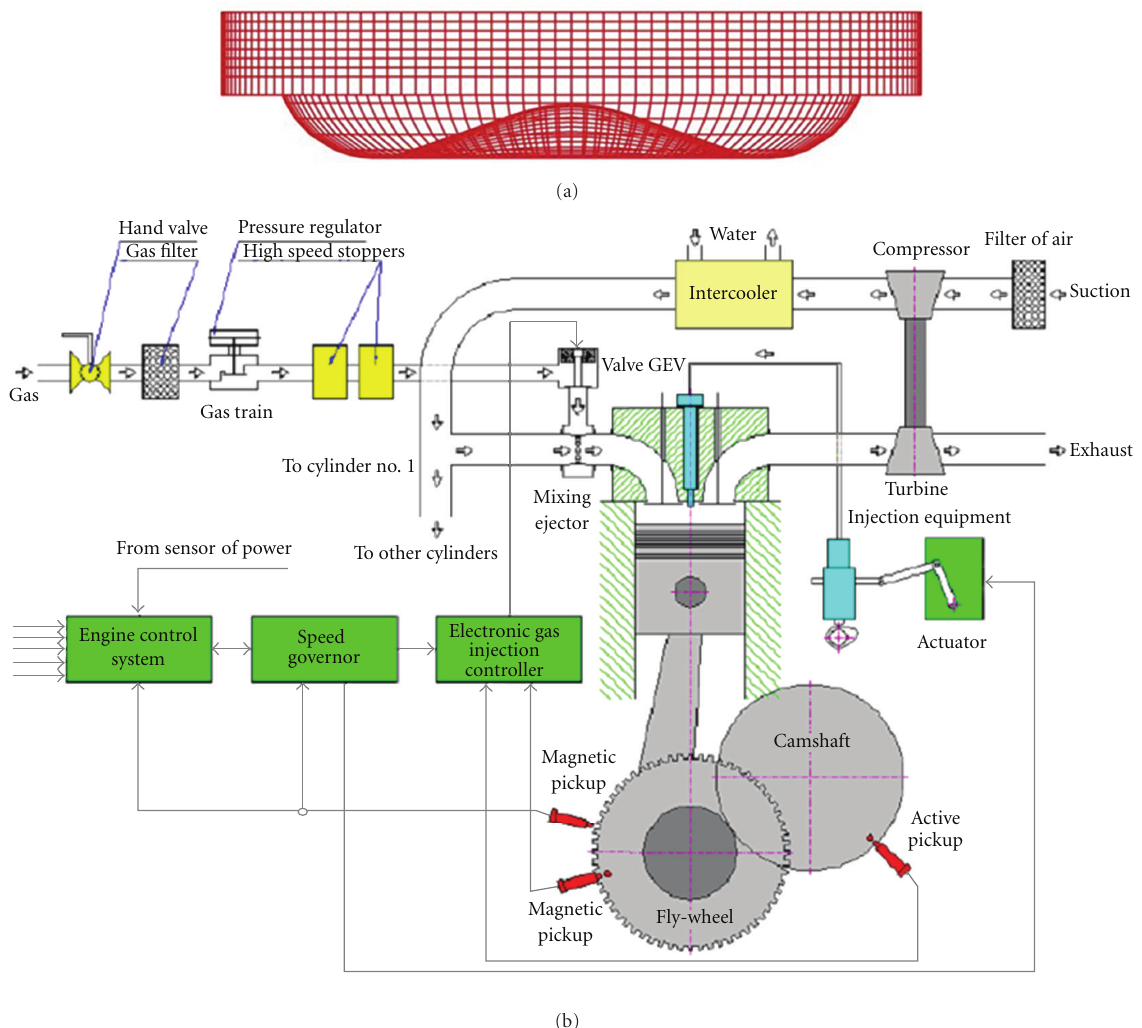
Figure 1: (a) Computational grid at TDC and (b) schematic of DF